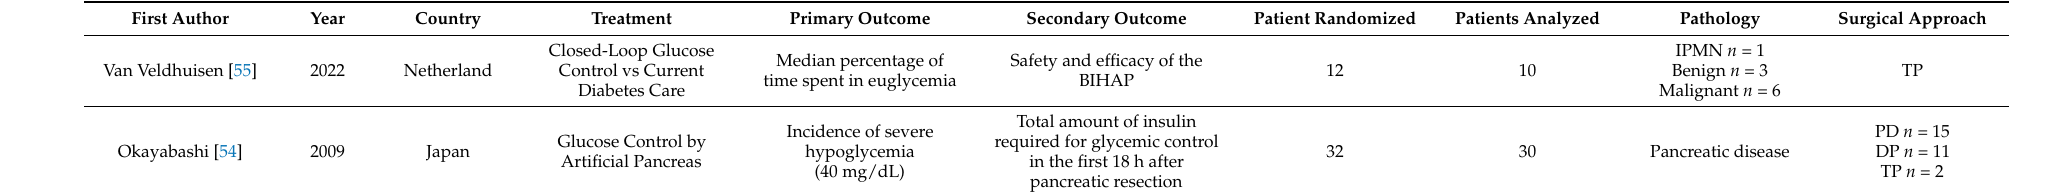
Table 5. Antidiabetic Drug